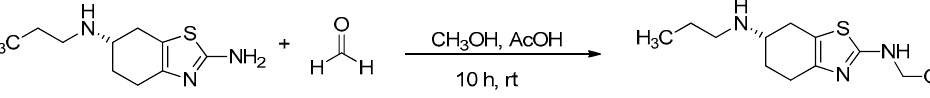
Figure 6. Synthesis of ( S )- N 2 -(methoxymethyl)- N 6 -propyl-4,5,6,7-tetrahydro-1,3-benzothiazole-2,6- diamine.